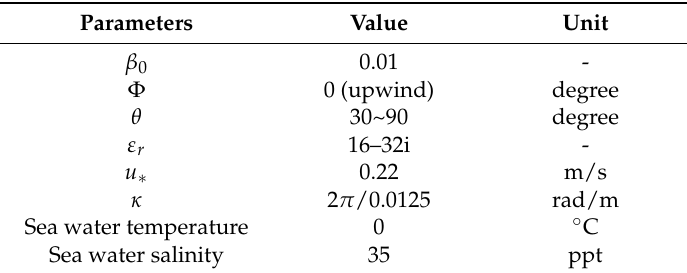
Table 2. NRCS calculation conditions.